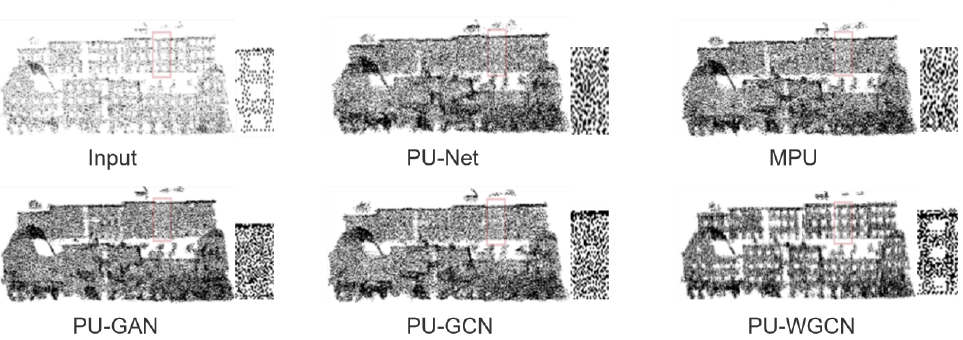
Figure 17. Visualization of the results in real scenes of group g. We perform upsampling operations on the building data. At the windows of the building, PU-WGCN preserves the hole and boundary information